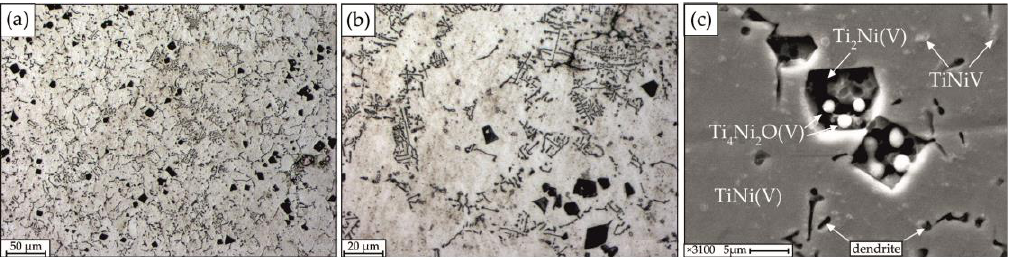
Figure 7. Microstructure of alloy No. 2 obtained on optical ( a , b ) and scanning electron microscopes ( c ).